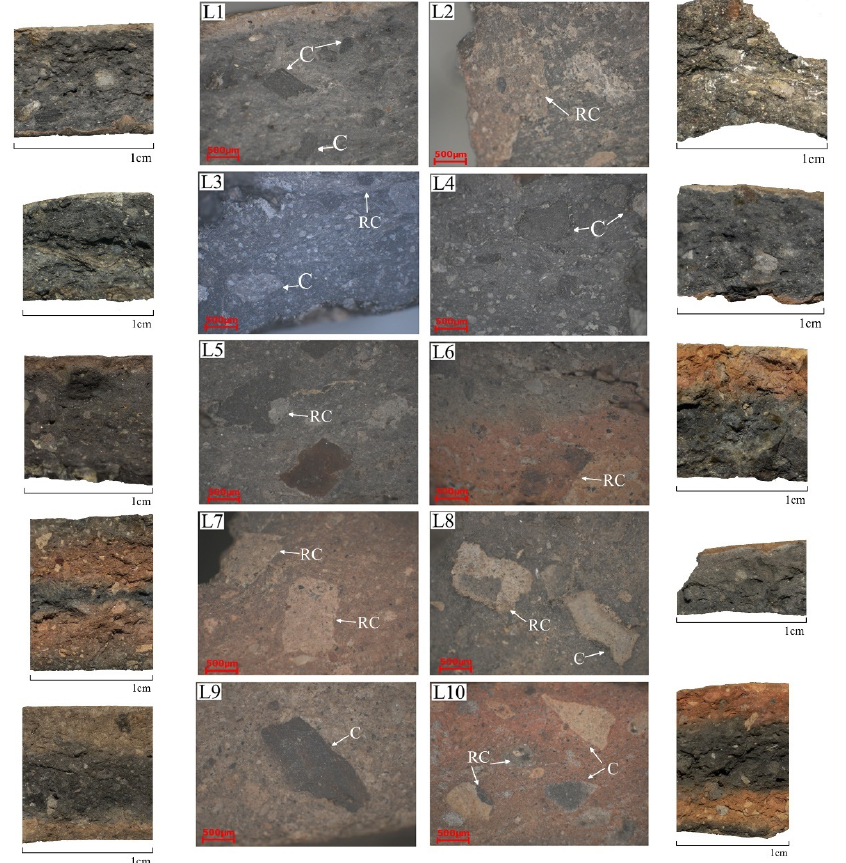
– Lut ă rie (C) ceramoclasts; ,